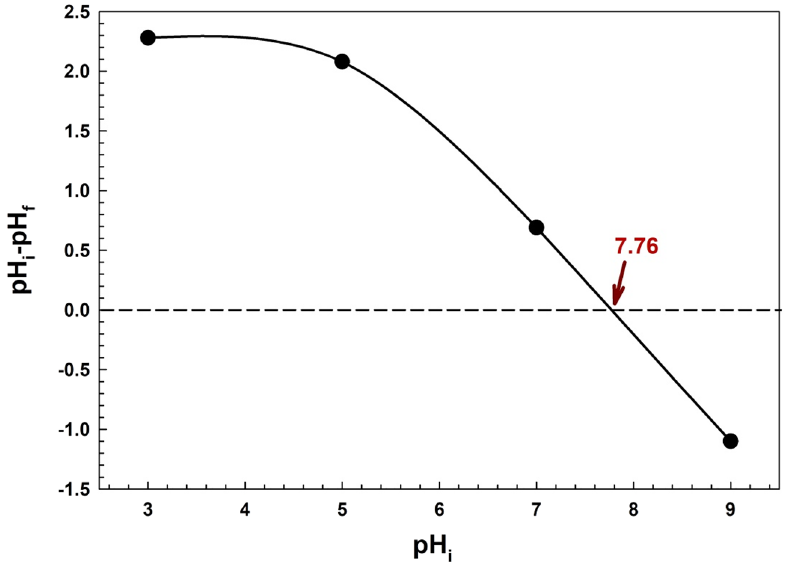
Figure 6. pH point of zero charge of